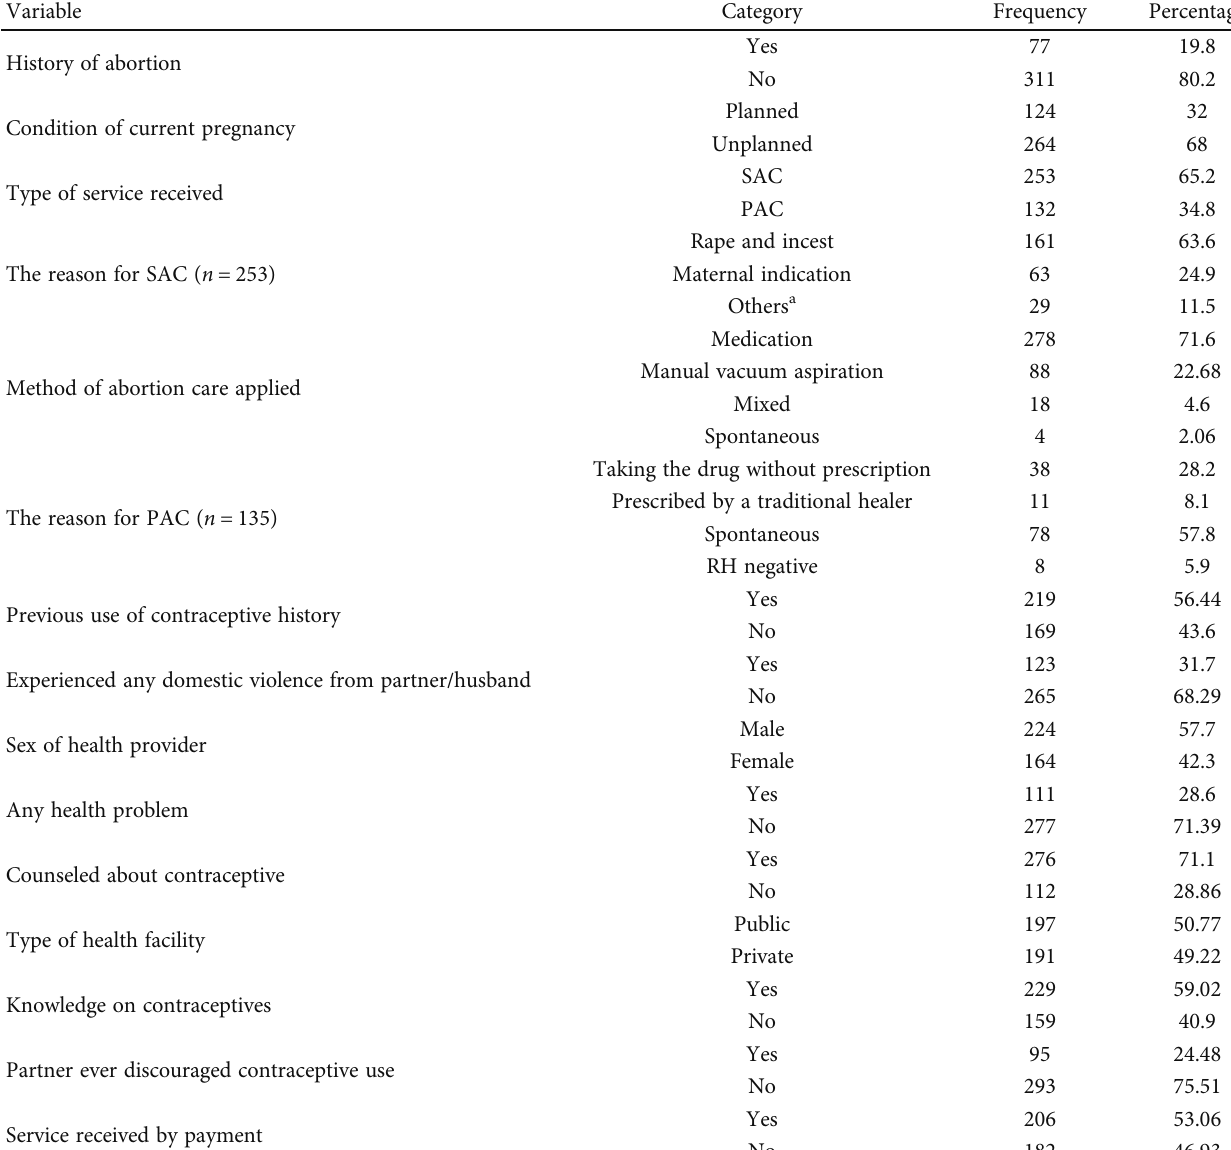
Table 2: Institutional, personal, and family factories of women who received abortion care services at health facilities in Ambo town, Oromia region, Ethiopia,